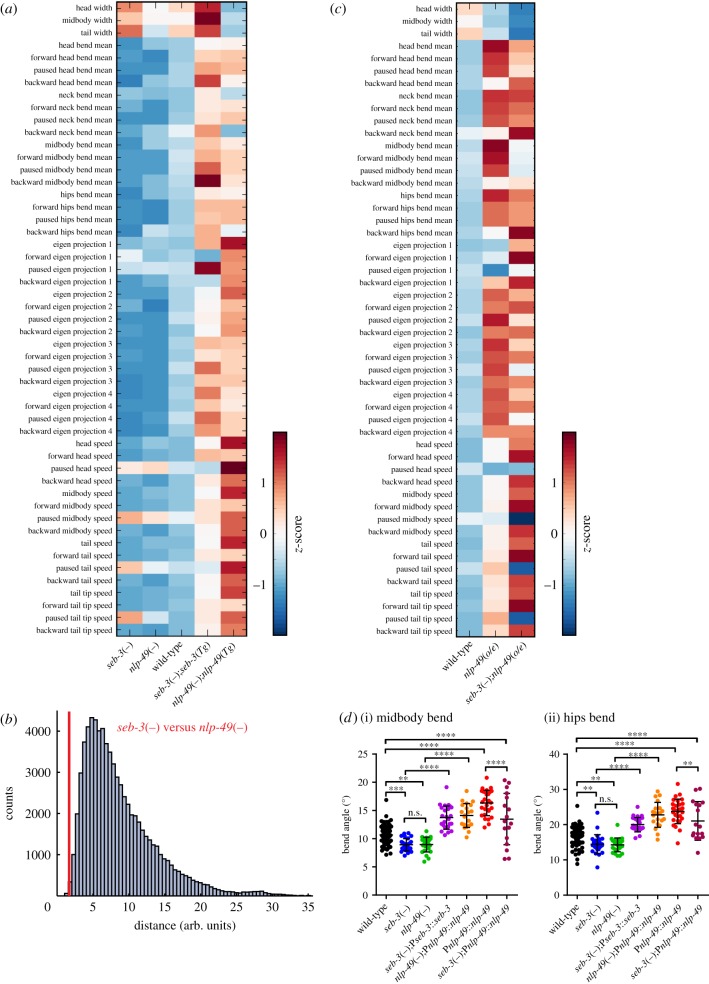
nlp-49 and seb-3 regulate locomotion. seb-3(tm1848) is referred to as seb-3(−) and nlp-49(gk546875) as nlp-49(−). (a) Heat map comparing behavioural phenotypes of wild-type, seb-3(−), nlp-49(−), seb-3(−);seb-3::seb-3 (seb-3 Tg), and nlp-49(−);nlp-49::nlp-49 (nlp-49 Tg). (b) Pairwise Euclidian distances (after z-normalization) for nlp-49(−) and seb-3(−) mutants compared with all previously tracked strains [19,20]. The y-axis indicates strain count. The comparison for seb-3 versus nlp-49 is shown in red. (c) Heat map comparing behavioural phenotypes of wild-type, nlp-49(o/e) and seb-3(−);nlp-49(o/e). For heat maps, the colours show the z-score of each feature calculated across all strains. (d) To identify features significantly different between wild-type and each single mutant, multiple t-tests were performed, controlling for false discovery rate (5%). Body bend features are compared between all genotypes tested. (i) Midbody bend angle, (ii) hips bend angle. Error bars indicate mean ± s.d. Statistical tests: one-way ANOVA, Holm–Sidak's post-test. p-values indicated by n.s., not significant, ** < 0.01, *** < 0.001 and **** < 0.0001. Raw data for all parameters are shown in electronic supplementary material, table S3. See also figure S1.